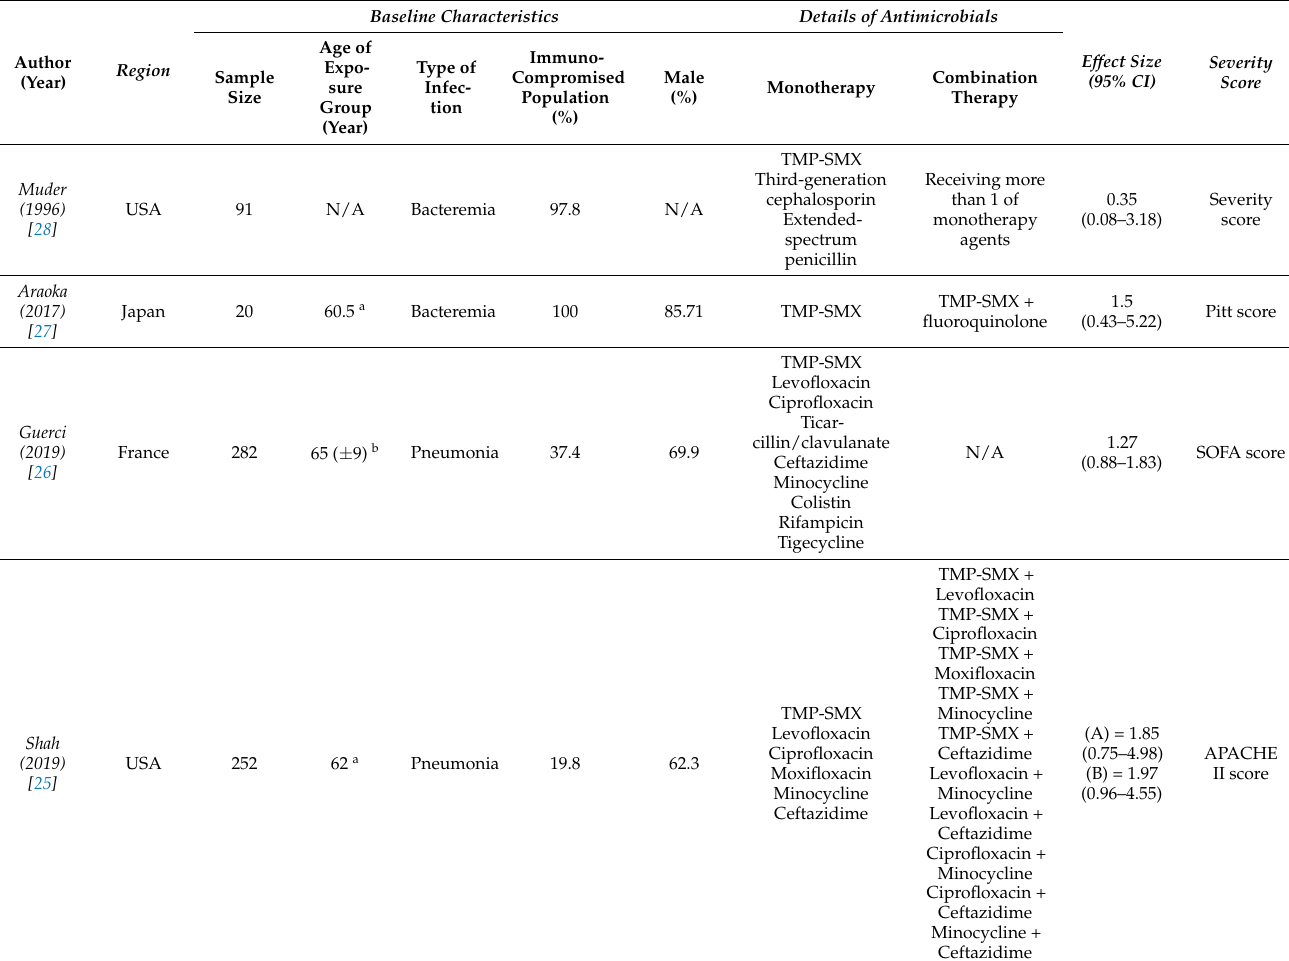
Table 2. Characteristics of cohort studies included in the systematic review and